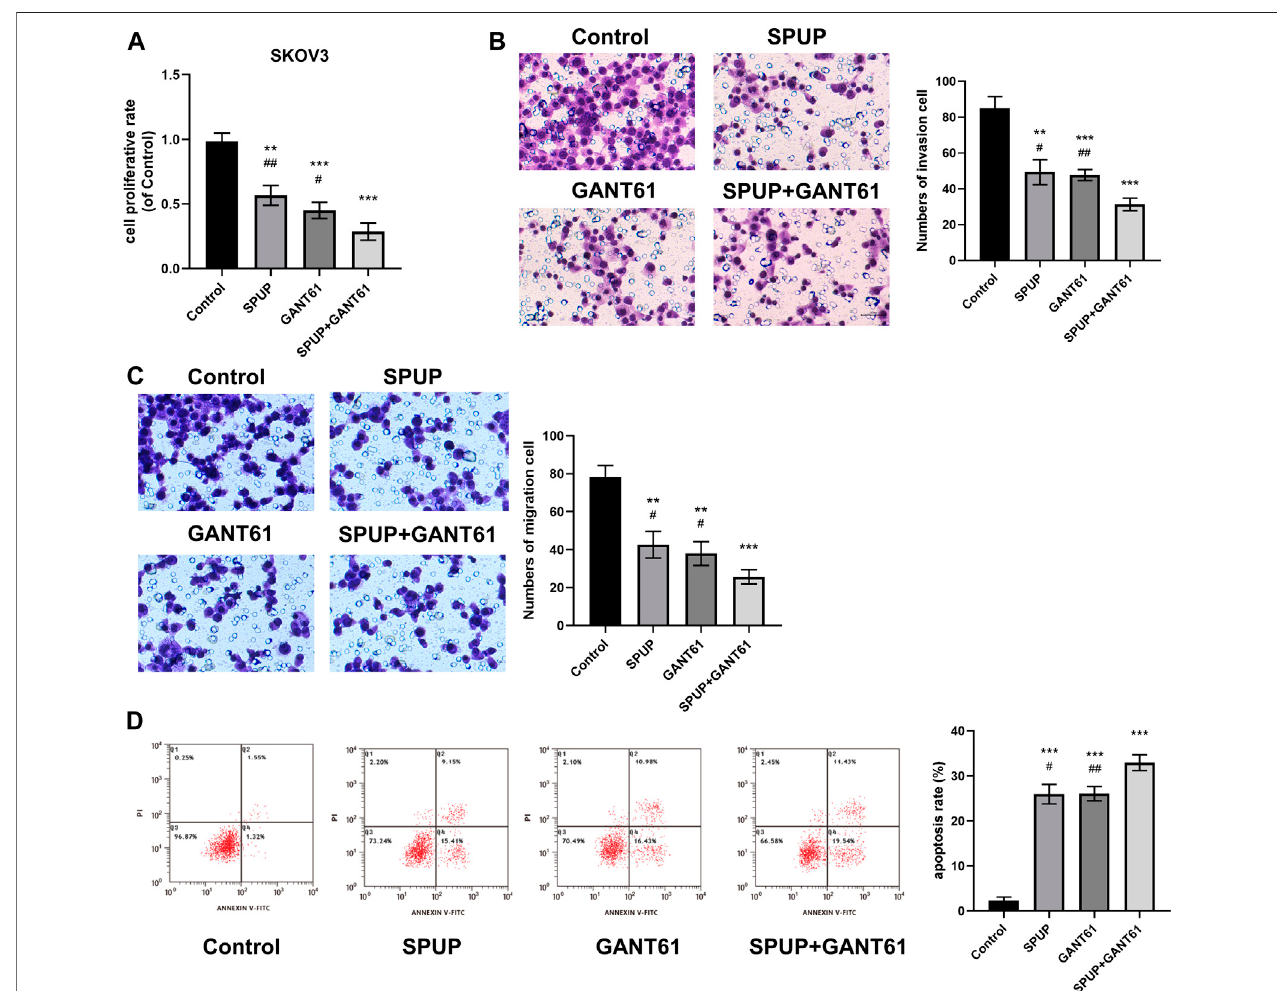
FIGURE 7 | SPUP plays a role in regulating cell function by inhibiting the activation of the Hh signaling pathway. (A) The CCK-8 method was used to determine the proliferationabilityofcellsaftertheHhpathwayinhibitorwasapplied; (B,C) theTranswellmethodwasusedtodeterminetheinvasionandmigrationabilityofcellsafterHh pathway inhibitor was applied; (D) the apoptosis of cells after the Hh pathway inhibitor was measured by fl ow cytometry. ** p < 0.01, *** p < 0.001 compared with the control group, # p < 0.01, ## p < 0.01 compared with the SPUP + GANT61 group.